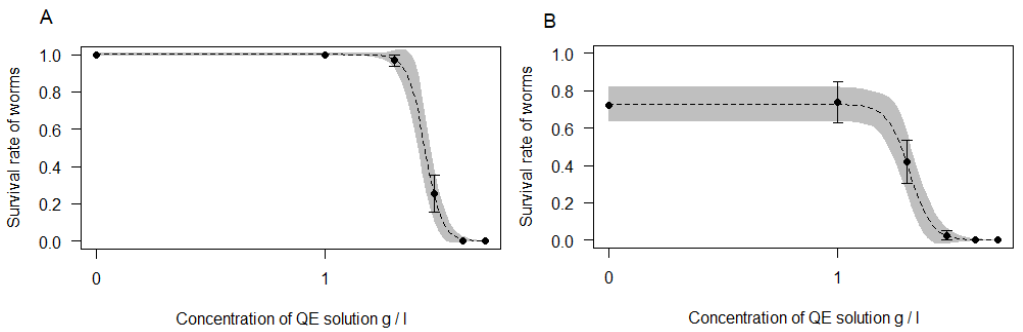
Figure 2. Dose–response curves for the toxicity of of Quillaja saponaria aqueous extract (QE) on: ( A ) E. albidus at 6 °C; ( B ) E. albidus at −1 °C. A grey band on the curve represents the standard error of the dose–response model. Black dots show the mean (with standard error bars) effect of the tested concentration of QE solution. Black dots represent tested concentrations of QE solution: 0; 1; 2; 3; 4; and 5 g/L.